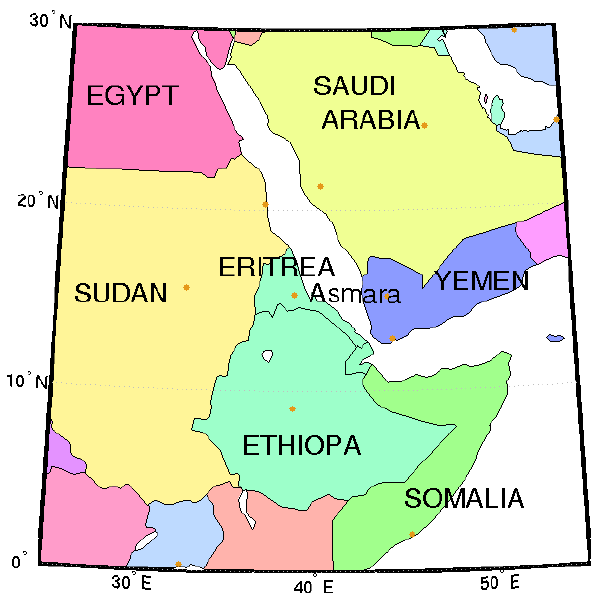
Fig. 1. Regional map of northeastern Africa showing Asmara near the center at 15.4 ◦ N, 38.9 ◦ E, 7 ◦ dip. The magnetic equator is at 9 ◦ N in this